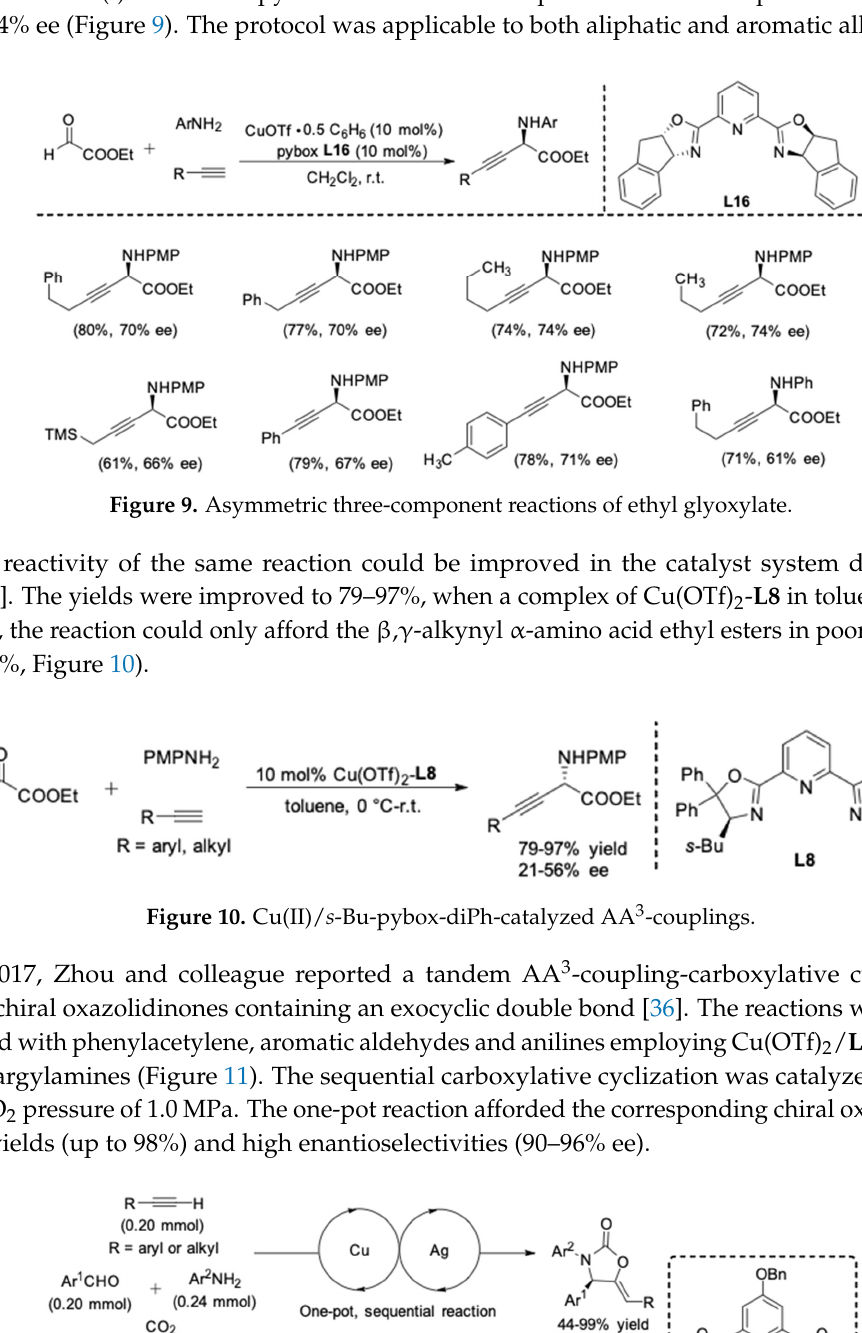
Figure 11 . Tandem AA 3 -coupling-carboxylative cyclization. Figure 11. Tandem AA 3 -coupling-carboxylative